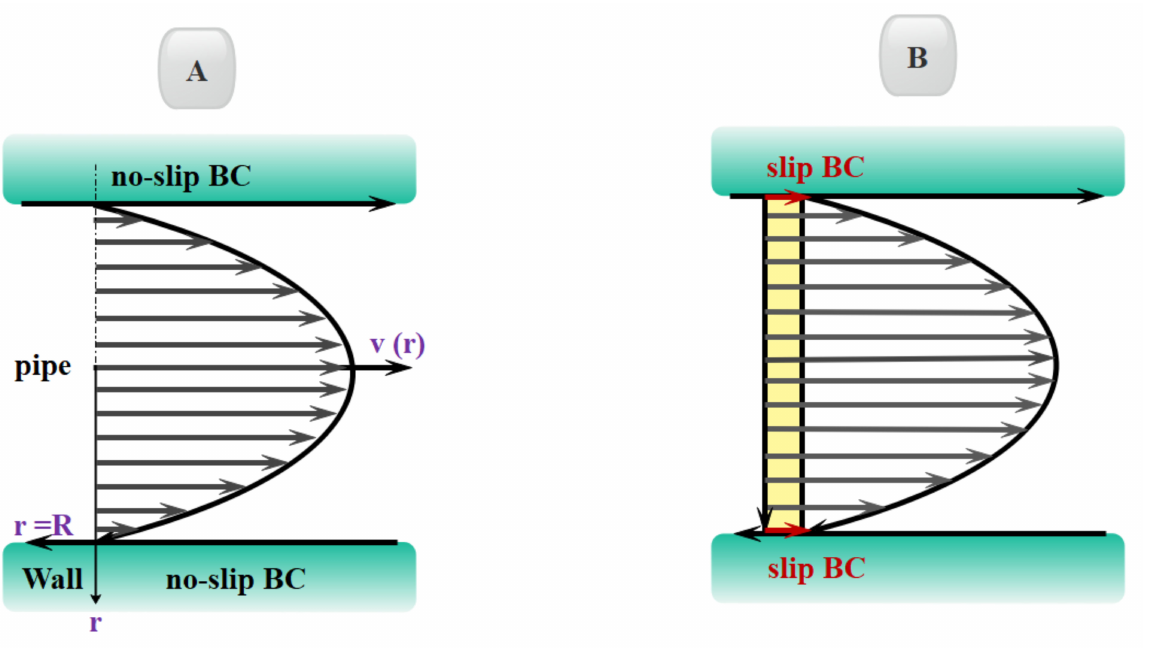
Figure 5. Velocity profile ( A ) in the absence and ( B ) in the presence of slip flow at walls